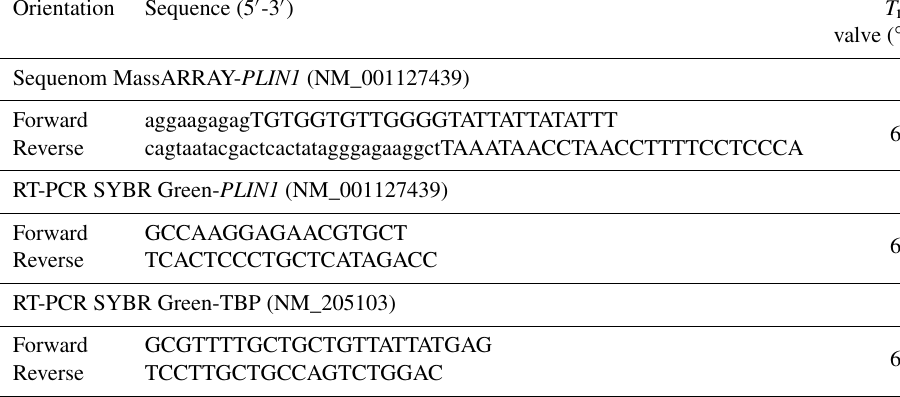
Table 1. Primers used.